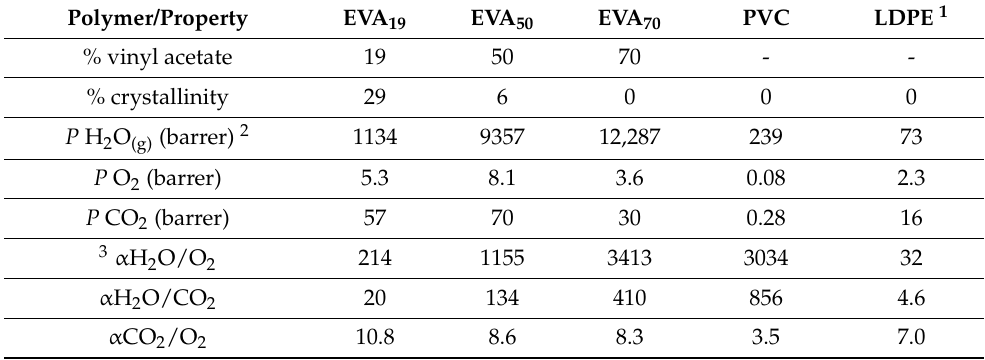
Table 4. Comparison of gas permeability coefficients at 25 ◦ C for EVA, PVC and PE.